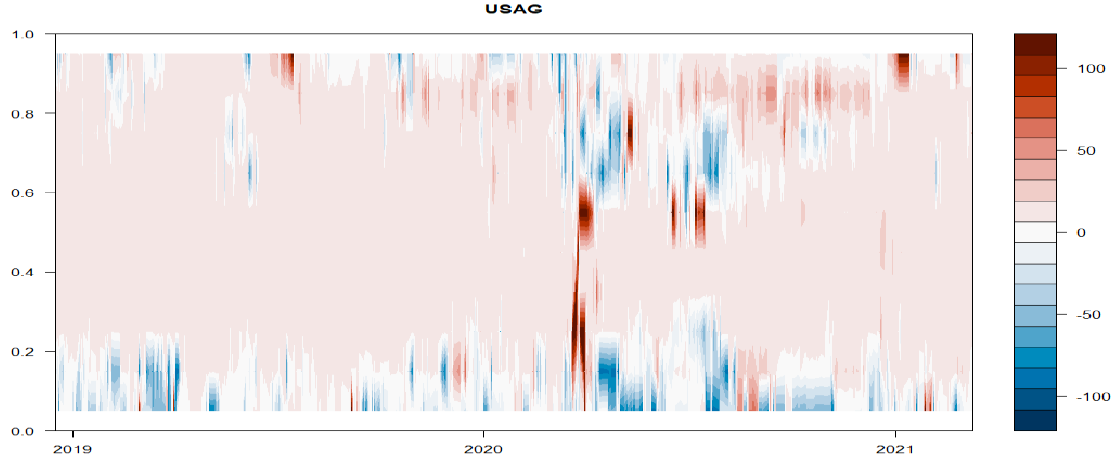
Figure 6. Results for net total directional connectedness for the S&P US Aggregate Bond Index based on a 200-day rolling-window QVAR(1) model and a 20-step-ahead forecast.